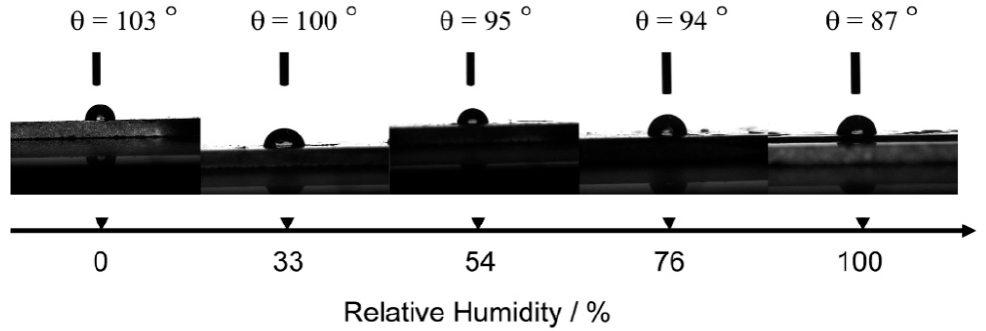
Figure 9. Water contact angle of the β -CD-TiO 2 /P(HEMA-co-BA) coating under different humidity conditions.